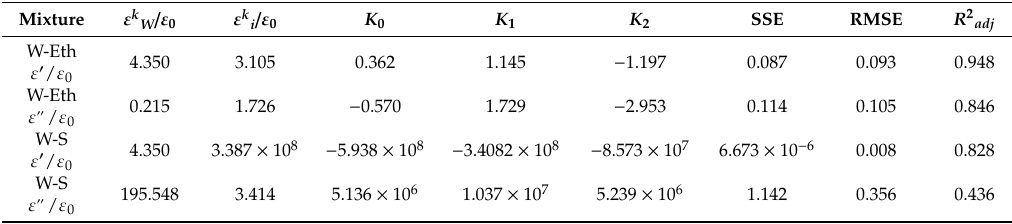
Figure 9. Measured values ( (cid:78) ), Acree model curve (---), and King and Queen model curve (–) of ε (cid:48) / ε 0 for the water–NaCl mixtures, reported as a function of water molar fraction ( x w ). All the values of the parameters used for the regressions and the related statistical indicators are reported for the Acree model in Table 1 while for King and Queen model in Table 2. Table 1. Values of the model parameters and statistical indicators of the regression carried out with the Acree model; the superscript K indicates the single or the double quotes, depending on the row (real or imaginary part of permittivity); the subscript i indicates the second component of the mixture, depending on the row (ethanol or NaCl).